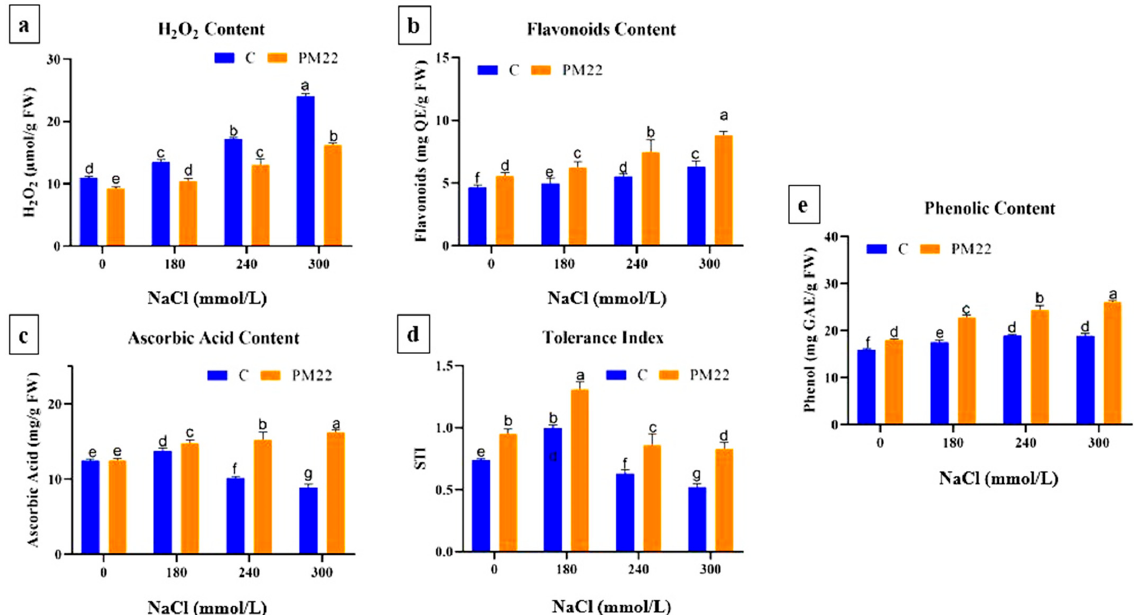
Figure 5. Impacts of various treatments on flavonoids, phenol, ascorbic acid contents, and salt tol- erance index of PM22-inoculated maize at different salt stress levels (0, 180, 240, and 300 mmol/L). Soil containing non-inoculated seeds and soil with seeds inoculated with B. Safensis (PM22) were the two treatments. The values are the averages of three triplicates with standard errors of the mean. Different alphabets have significantly different values ( p = 0.05) from each other, according to Tukey’s least significant difference test.